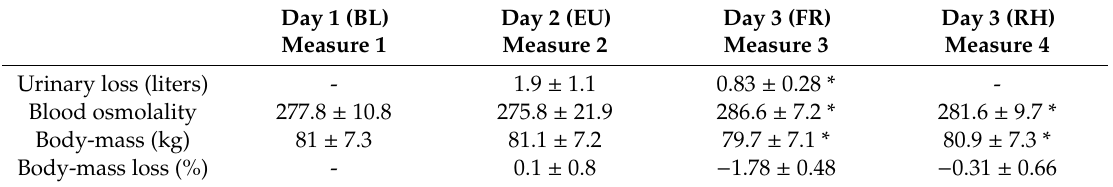
Table 4. Body mass, body-mass loss, urinary loss and blood osmolarity measurements during the